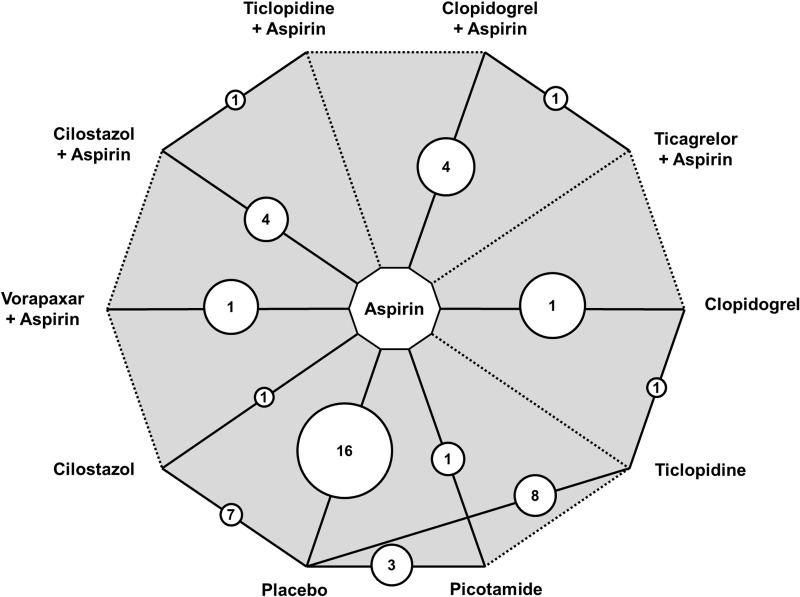
Network of evidence.Straight lines denote direct head-to-head comparisons and dotted lines denote indirect comparisons where direct comparison data is missing. Numbers refer to the number of RCTs with direct comparisons available for each link and the size of circles is proportional to the pooled sample size (person-years) available for each direct comparison.